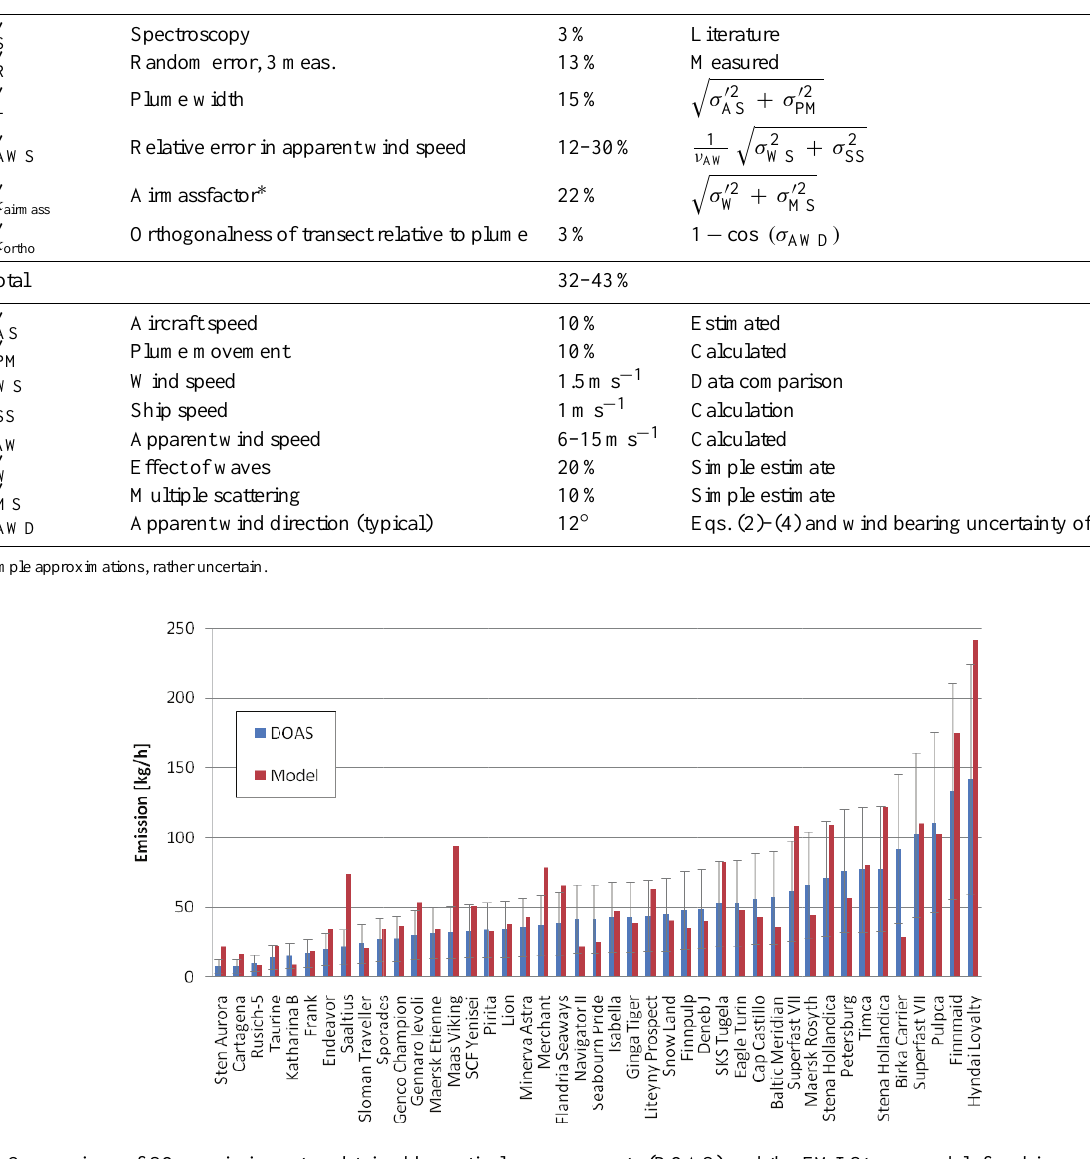
Fig. 13. Comparison of SO 2 emission rates obtained by optical measurements (DOAS) and the FMI-Steam model, for ships on the Baltic and North Sea during 2008 and 2009, respectively. The measurement error bars correspond to 40%